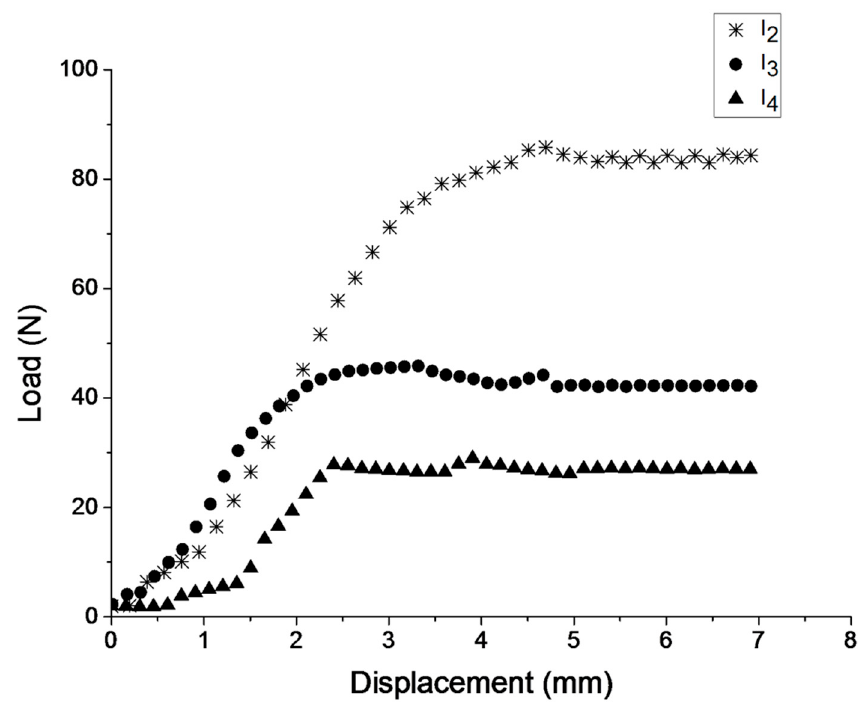
Figure 2. Representative injection curves (load vs. plunger run) corresponding to titanium inks with di ff erent metal powder different metal powder fractions.